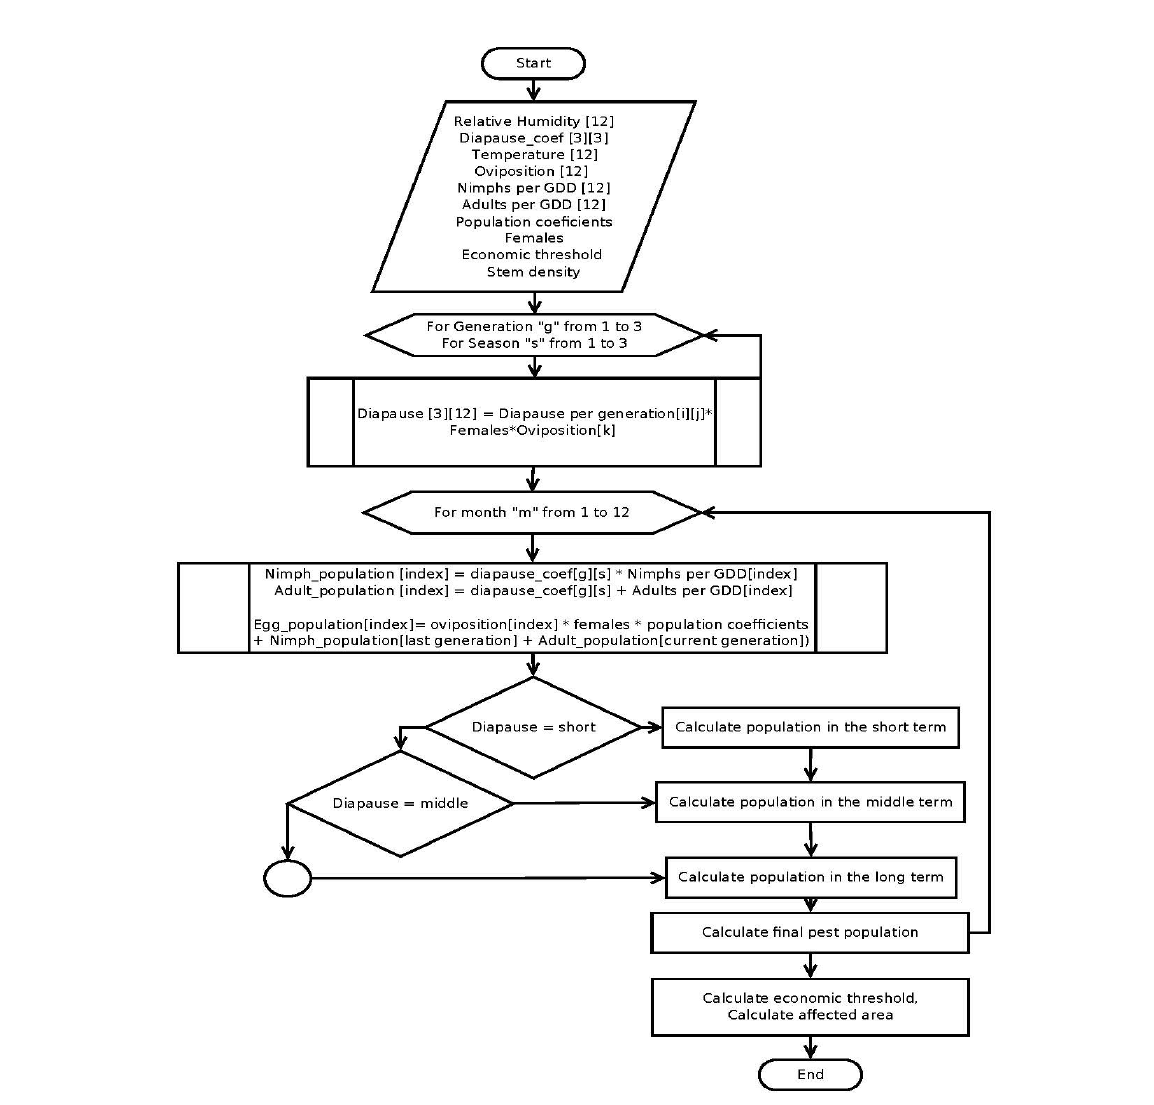
Figure 1: Simplified flowchart of the algorithm, with emphasis on the input data required for the numeric simulation. The clause [3] refers to each iteration for the three known diapauses, and [12] is the number of monthly iterations and data used for calculations; the arrays modeling diapause are bi-dimensional because three ratios of diapause are present for different periods throughout the year